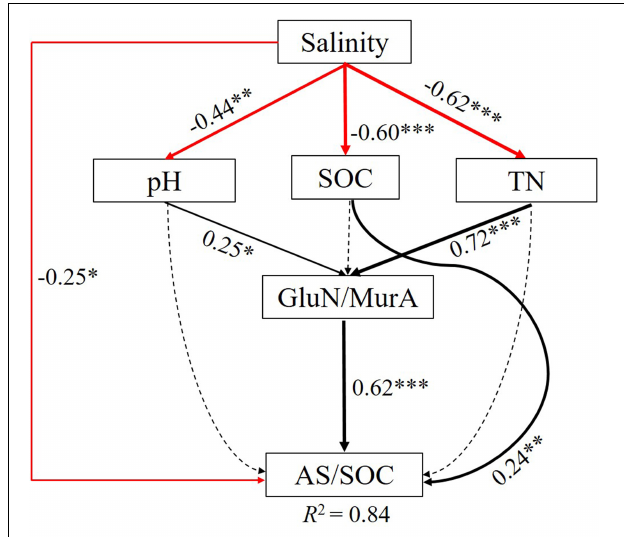
in the decrease in microbial AS. In addition, the SOM was not easily utilized by soil microorganisms with a low decomposition rate (Steinmuller and Chambers, 2019; Ward, 2020), which is likely to result in low AS synthesis.